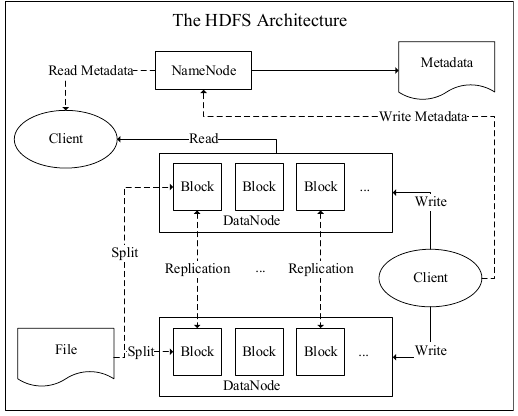
Figure 1. The HDFS